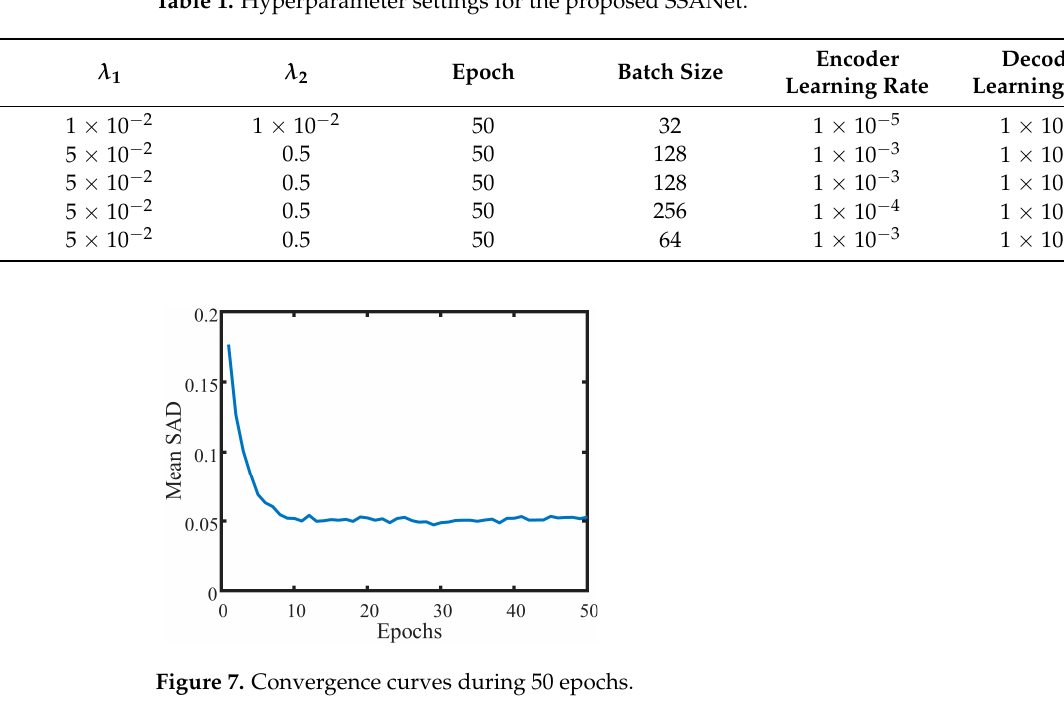
Table 1. Hyperparameter settings for the proposed SSANet.